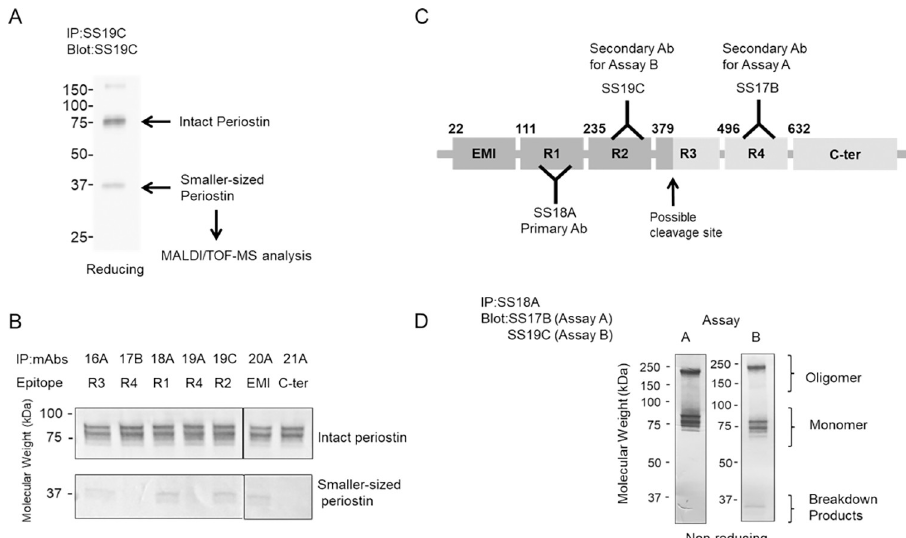
Fig 1. Identification of smaller periostin fragments. (A) Immunoprecipitated proteins by SS19C blotted by SS19C. The arrows indicate intact periostin and smaller-sized periostin. The smaller product was cut from the gel and subjected to MALDI/TOF-MS. (B) Reactivities of cleaved periostin against anti-periostin mAbs. Periostin purified from human serum was immuno-depleted by SS16A, SS17B, SS18A, SS19A SS19C, SS20A, or SS21A. Western blotting of the immunoprecipitate by the indicated mAbs, followed by blotting with SS19C under reducing conditions is depicted. (C) Antibody binding sites in the original (Assay A) and novel (Assay B) periostin ELISA systems. The arrow indicates the possible cleavage site of the smaller-sized product of periostin. Dark gray parts indicate the composition of the smaller-sized periostin. The capturing mAb (SS18A) and secondary mAbs (SS17B and SS19C) used in Assay A and Assay B are shown. (D) Reactivities of periostin for Assay A and B showing periostin oligomers, monomers and smaller-sized periostin fragments.